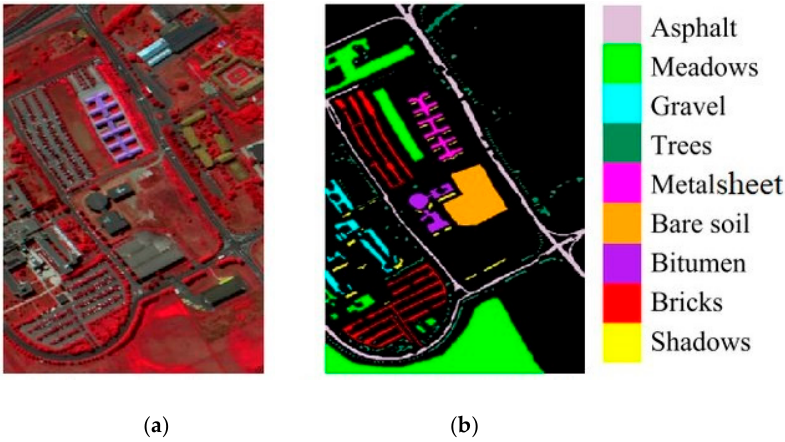
Figure 4. ROSIS PU data: ( a ) false color RGB image; ( b ) ground truth image. Table 1. Summary of the HSI datasets.